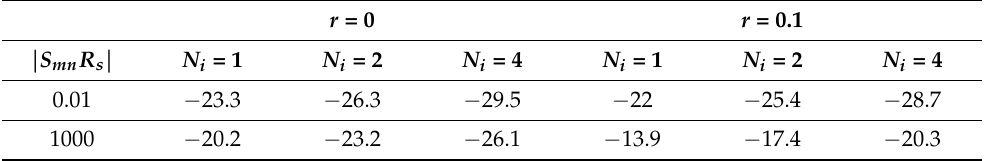
Table 2. Maximum acceptable ICXT level (dB) per interfering core to achieve OP = 10 − 4 , with L = 80 km. r = 0 r = 0.1 | S mn R s